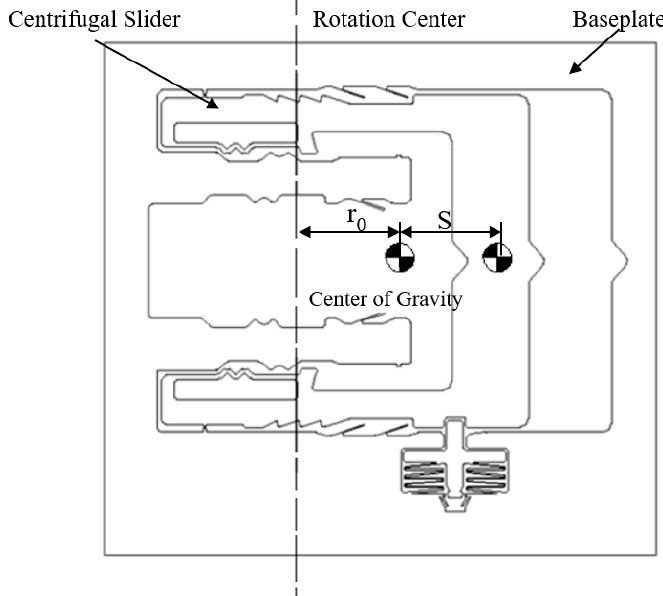
Figure 3. The center of gravity, rotation center, and stroke of the centrifugal slider.